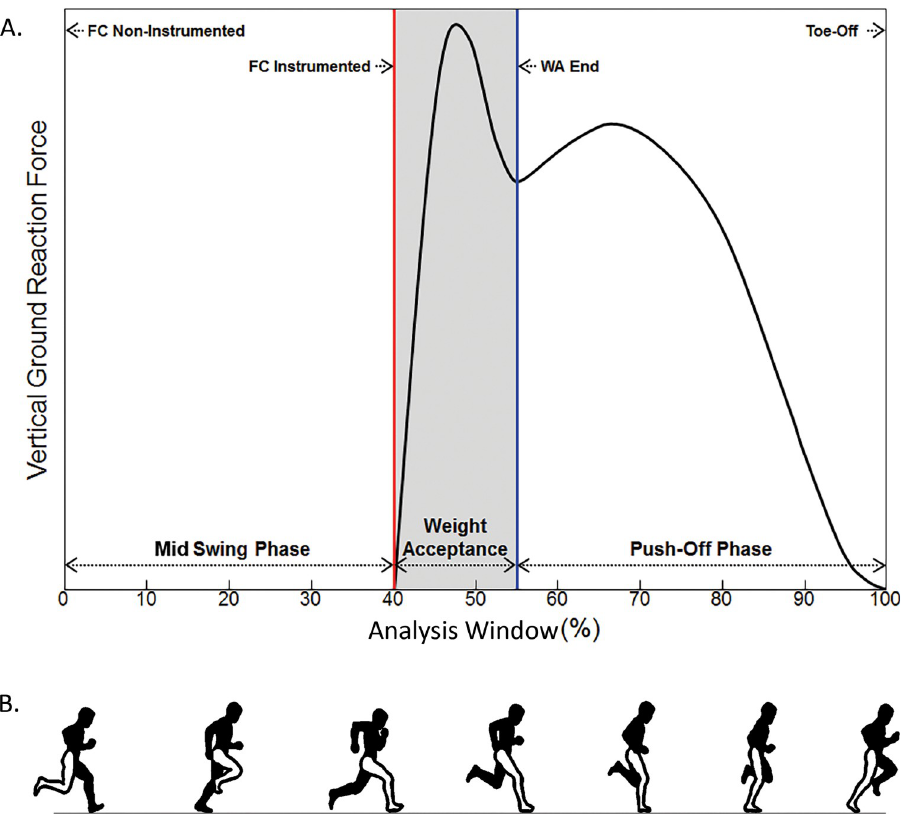
Fig 1. Visualization of the ground reaction force at corresponding phases of the stride cycle. (A.) Temporal events: foot-ground contact of the non-instrumented leg (FC Non-Instrumented), foot-ground contact of the instrumented leg (FC Instrumented), end of weight acceptance phase (WA End), and toe-off (Toe-Off). Analysis Window (%) starts with FC Non-Instrumented and ends with Toe-Off of the instrumented leg. (B.) Instrumented leg depicted in white. Phases of the stride cycle correspond to the Analysis Window (%) in Fig